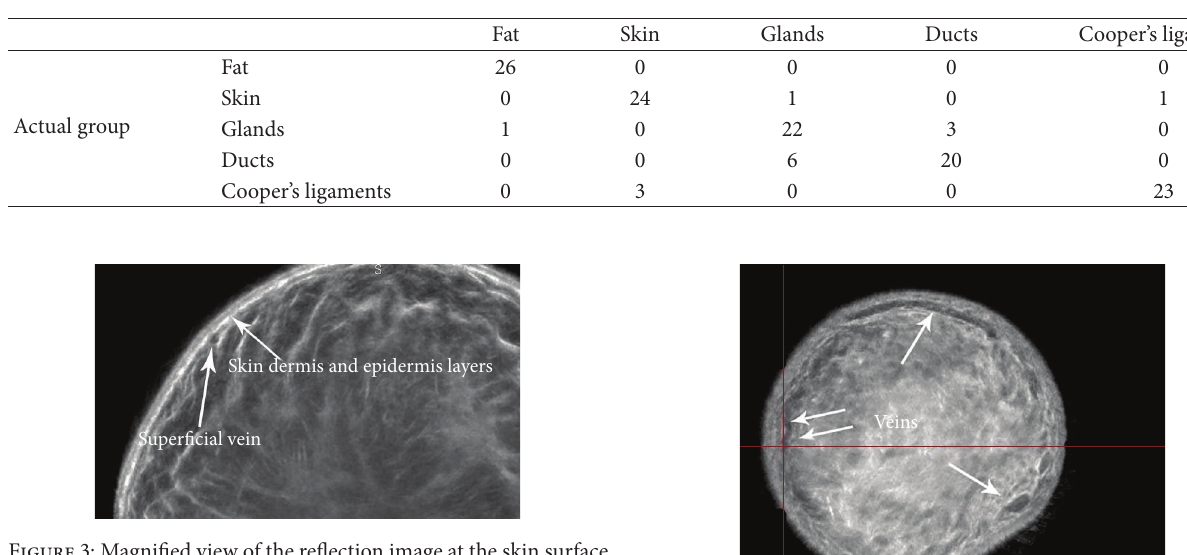
Figure 2: Cadaver cut surface photograph (left) and reflection image (right) at the areola. The tissue (white in both images) represents Cooper’s supporting ligaments and fibroglandular tissue. The hypodermis (subcutaneous fat) is shown as black in the reflection image (right) and yellow in the cut section (left). Table 1: Classification matrix for the LDA of different normal breast tissue types. The overall accuracy of the separation of tissues using LDA was 88.5%.